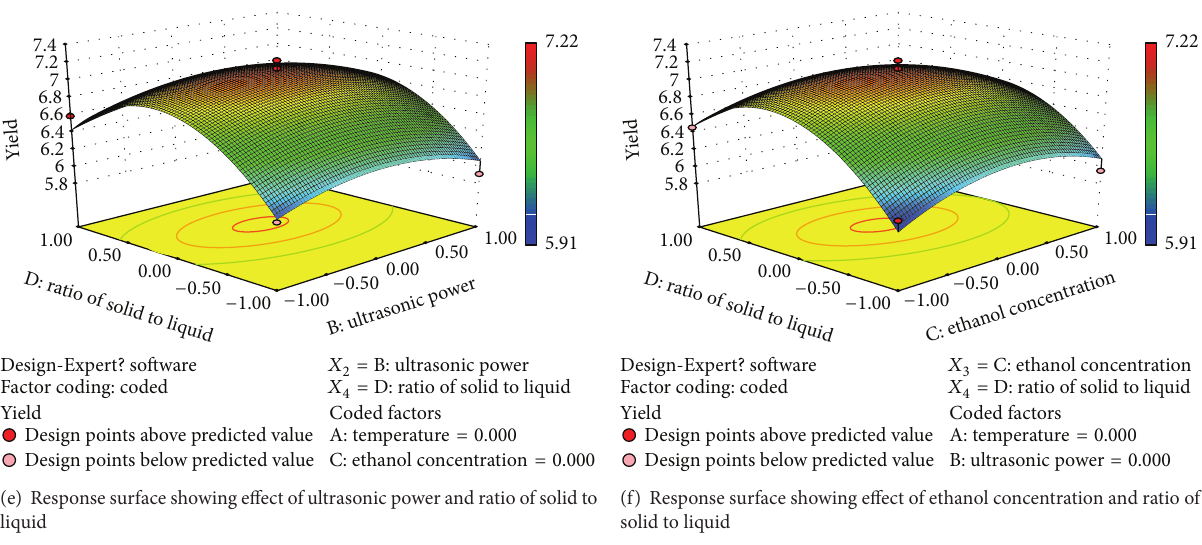
(f) Response surface showing effect of ethanol concentration and ratio of solid to liquid Figure 2: Response surface plot optimization of extraction yield between